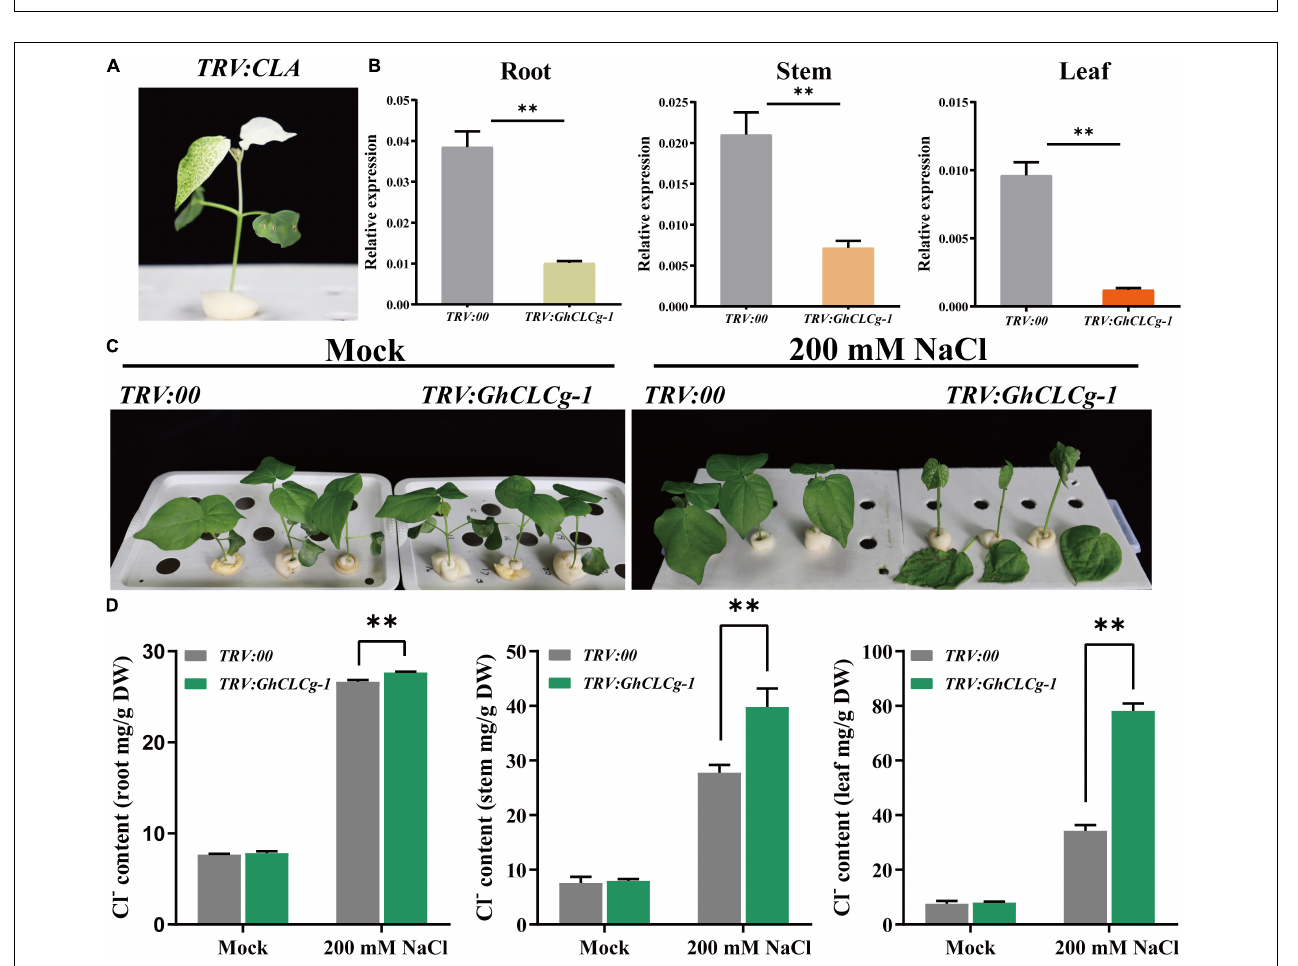
FIGURE 7 | Effects of silencing GhCLCg-1 in upland cotton. (A) The TRV:CLA plants (positive control) exhibited an albino phenotype. (B) Efficiency of the silencing of GhCLCg-1 in TRV:00 and TRV:GhCLCg-1 plants analyzed by qRT-PCR with GhHIS3 used as an internal control. (C) Phenotypes of TRV:00 and TRV:GhCLCg-1 plants treated with 0 mM (Mock) or 200 mM NaCl for 3 days. (D) Cl − contents of TRV:00 and TRV:GhCLCg-1 plants after the salt treatment. Data are presented as the mean ± standard deviation (SD) of three biological replicates ( ∗∗ p < 0.01, t